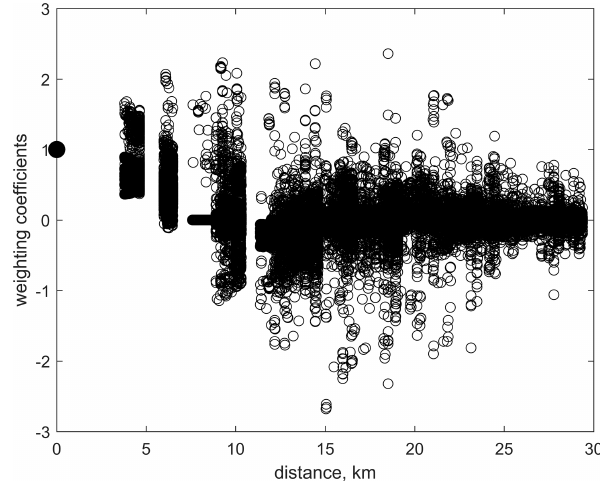
Figure 6. Distribution of the weights p i against the distance (cid:107) r − r i (cid:107) . They are computed between the node on the fine mesh 0 r 0 and those points on the medium mesh which are used for calcu- lation of the correlation matrix r i . The plot includes approximately 2.5million weights calculated for all the fine mesh nodes at the sur- face of the Red